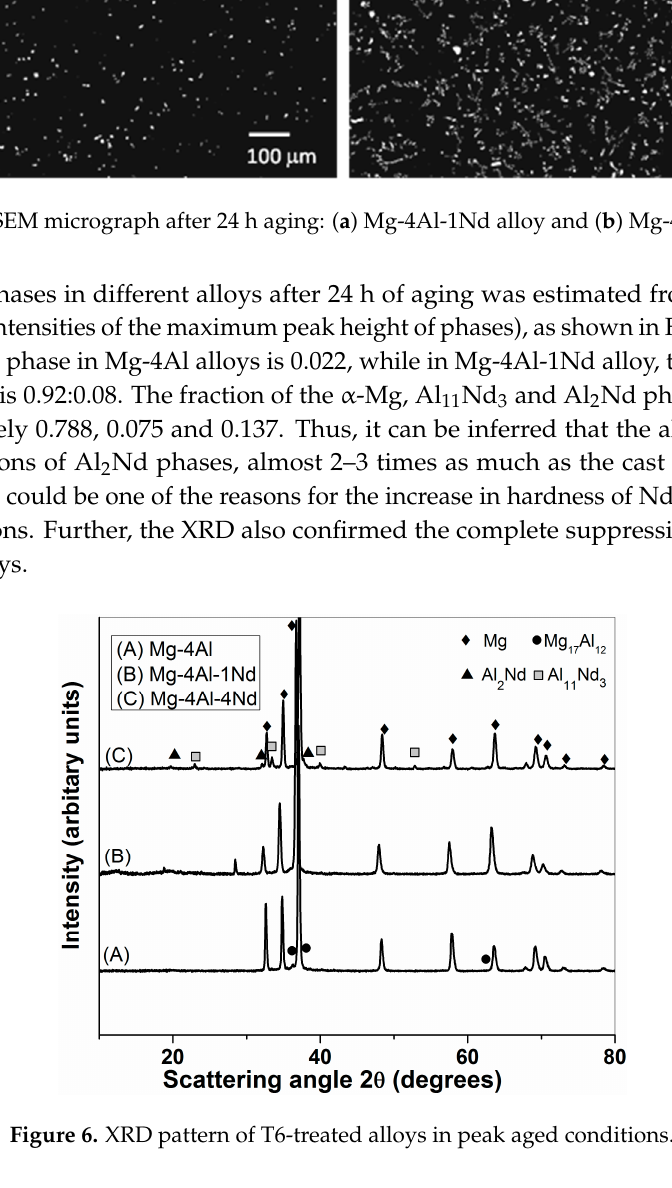
Figure 4. FESEM micrograph of Mg-4Al-4Nd at higher magnifications.